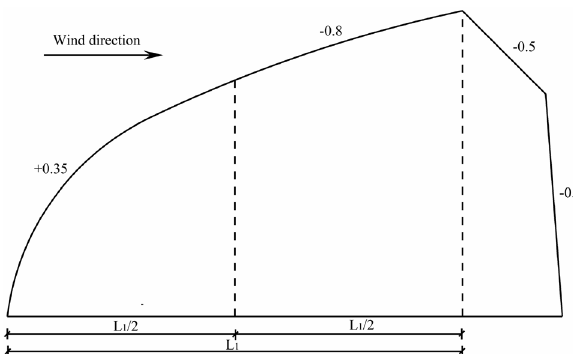
Figure 6. Shape coefficient of wind load on the